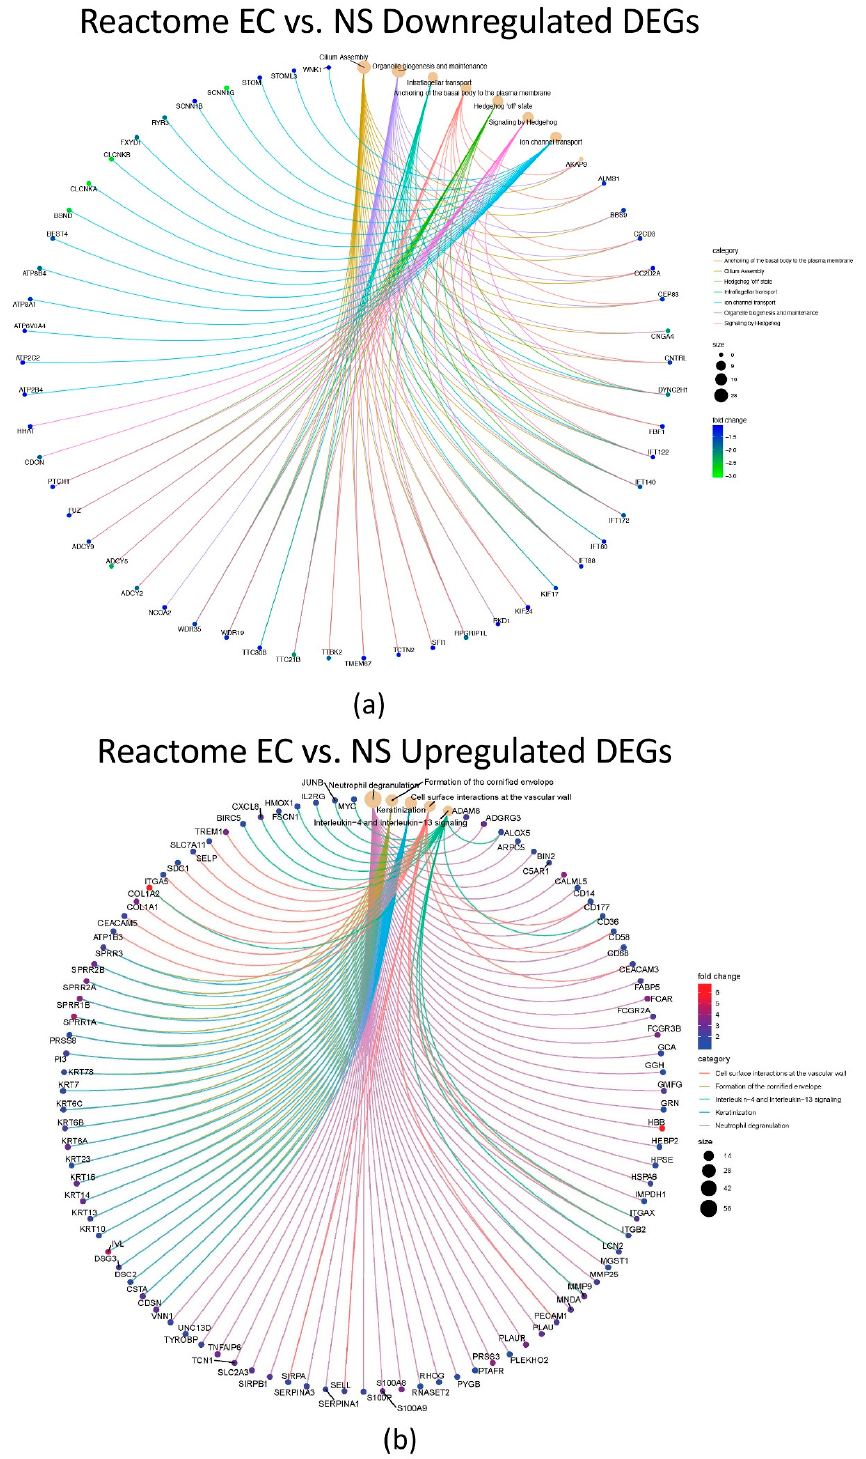
Figure 3. Top altered Reactome pathways and associated DEGs in the EC vs. NS set. ( a ) Pathways (light brown circles) enriched by downregulated DEGs in the EC vs. NS set. ( b ) Pathways (light brown circles) enriched by upregulated DEGs in the EC vs. NS set. Diagram shows the DEGs associated with each pathway and their fold changes (color key on right). Circle size key indicates the number of genes associated with each pathway. For ( a ), cilia assembly transcripts were down regulated. For ( b ), neutrophil degranulation was the major pathway. Images can be enlarged to read